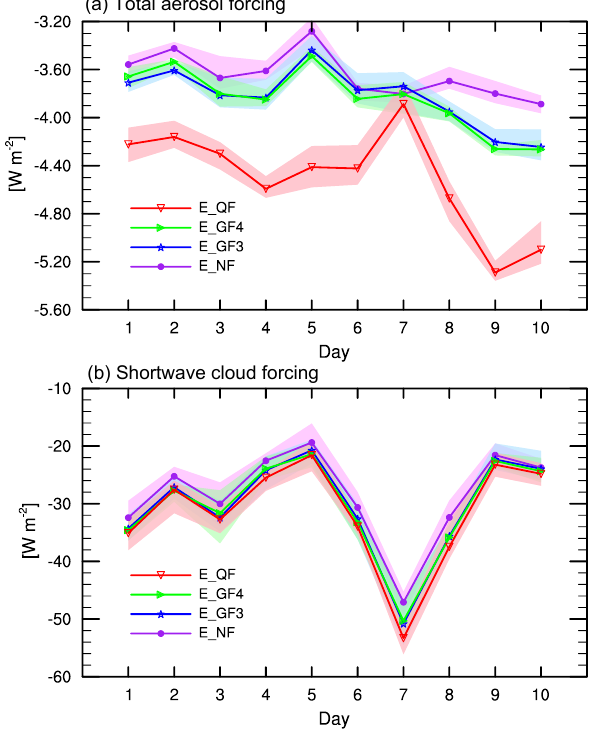
Figure 13. Time series of daily regional mean total (a) aerosol forc- ing and (b) cloud forcing in southern Mexico during 1–10 April 2009 in group B simulations. Individual lines indicate ensemble mean values. Shaded areas illustrate the ensemble spread (from minimum to